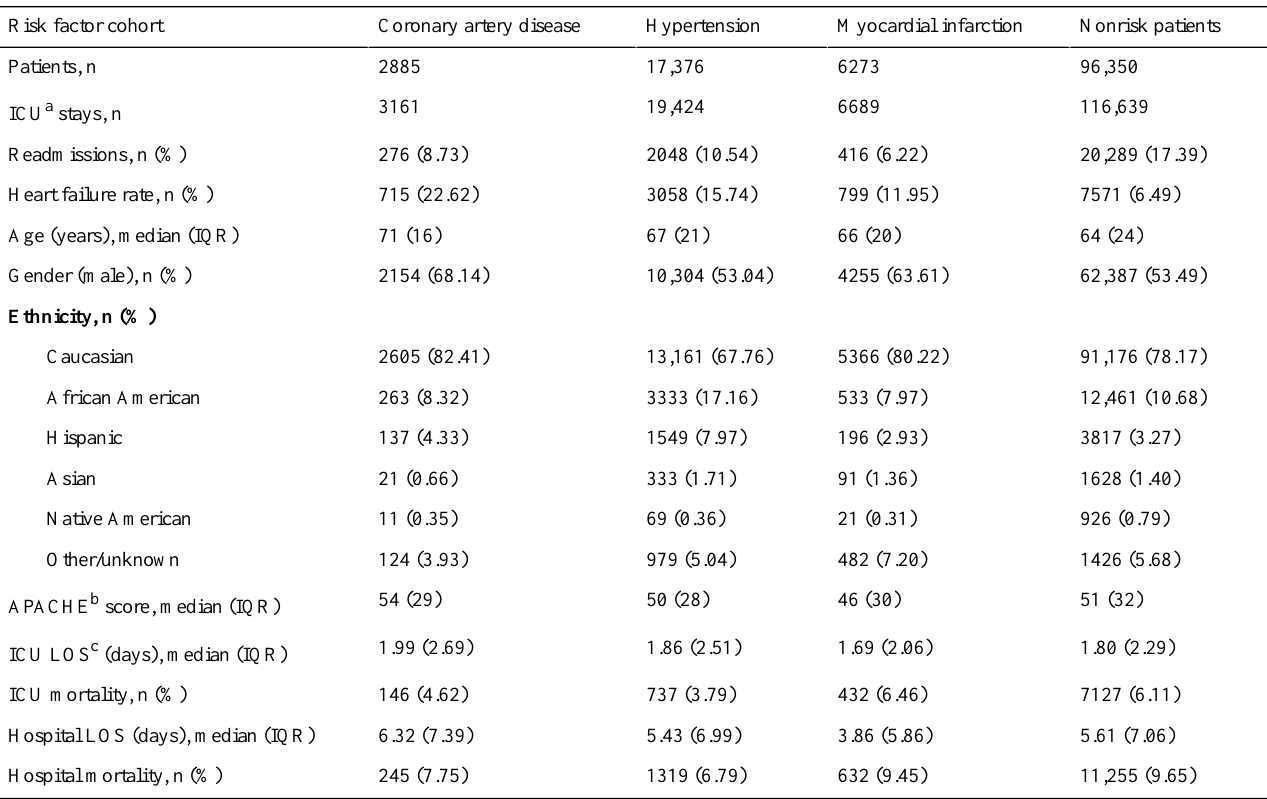
Table 2. Heart failure and nonheart failure patient